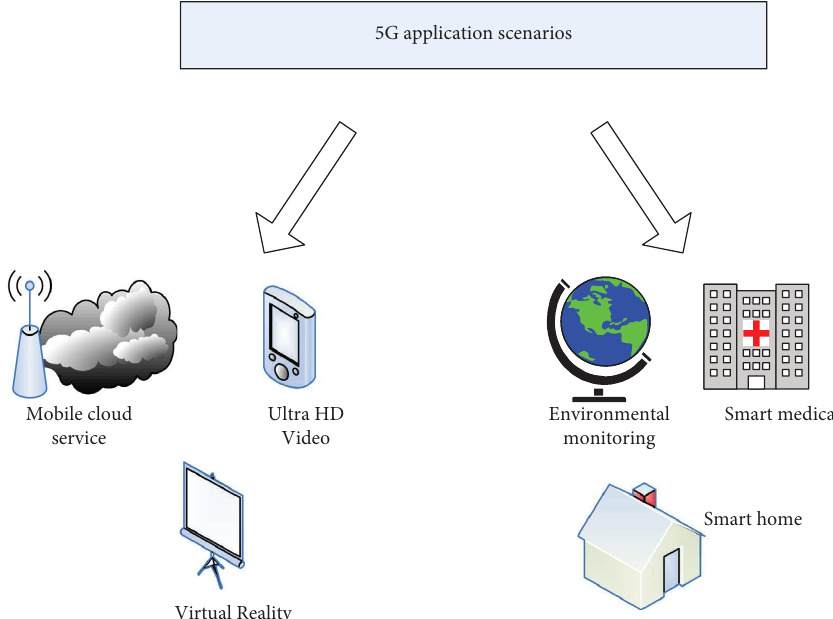
Figure 3: 5G technology application